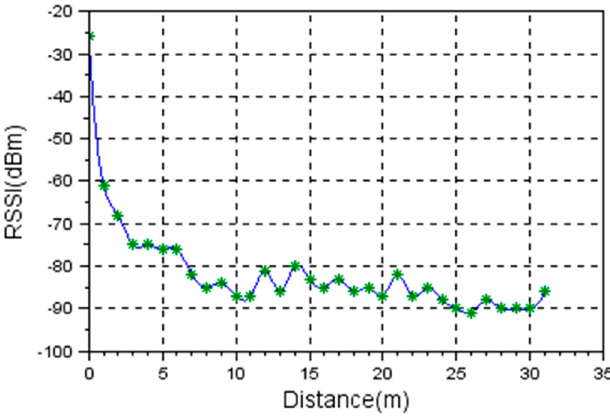
Figure 15. RSSI level vs. Distance. Open field measurements.